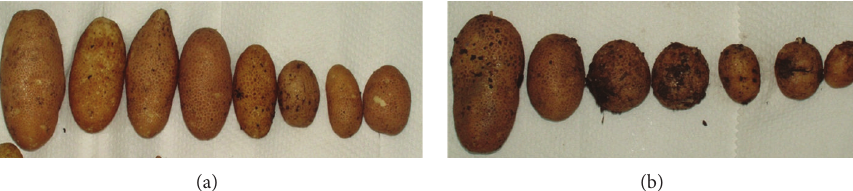
Figure 2: Typical severity of black scurf on potato somaclonal variants (a) A380 and (b) the parent cv. Russet Burbank. Tubers were from glasshouse trial 1 and the pathogen strain Rhizoctonia solani AG3 isolate R299